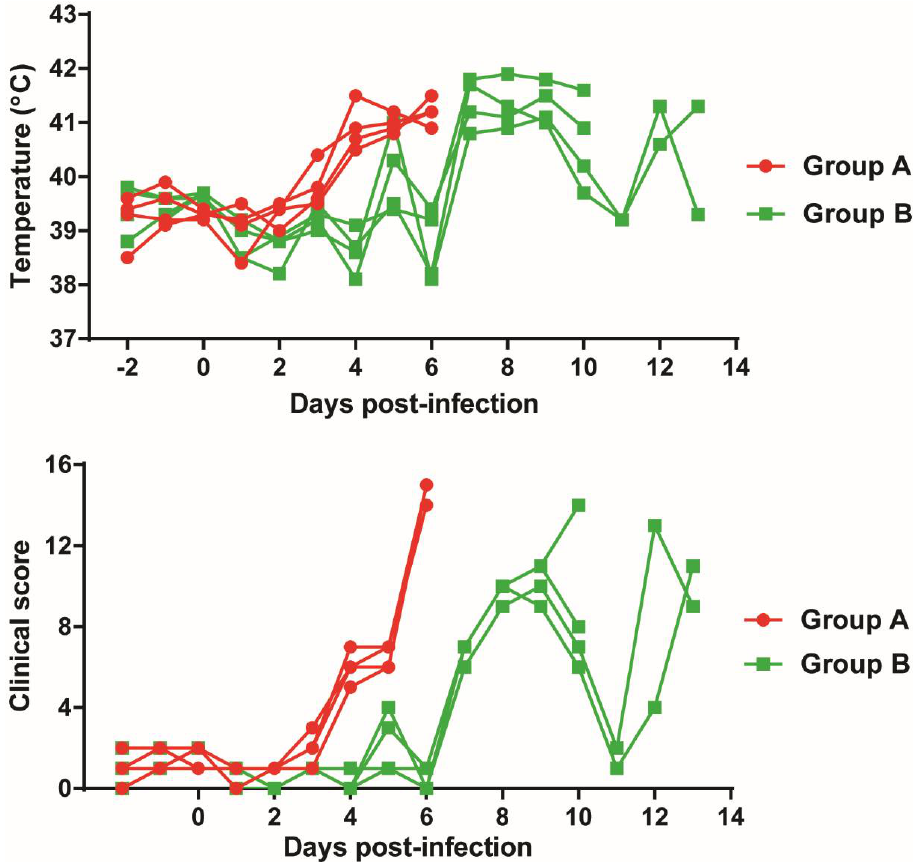
Figure 3. Temperatures and clinical scores . Pigs were immunized with either Georgia∆DP148R (Group A) or Georgia∆K145R∆DP148R (Group B). ( A ) Line graphs show the daily rectal temperatures of infected pigs. ( B ) Cumulative clinical scores, based on clinical signs, observed daily, are shown.